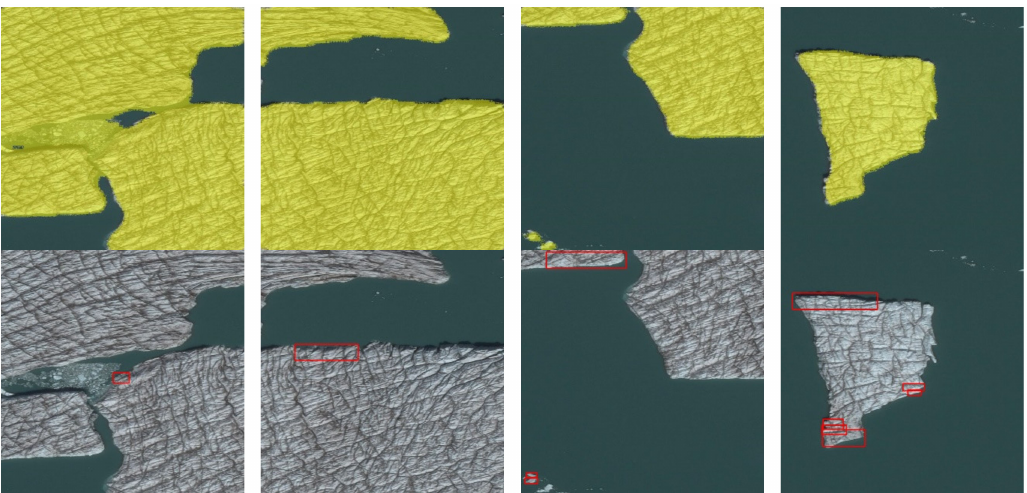
Figure 22. The detection result for iceberg scenes by using the Mask-Faster R-CNN and Faster R-CNN, and the first row is result of the Mask-Faster R-CNN and the second row is result of the Faster R-CNN.